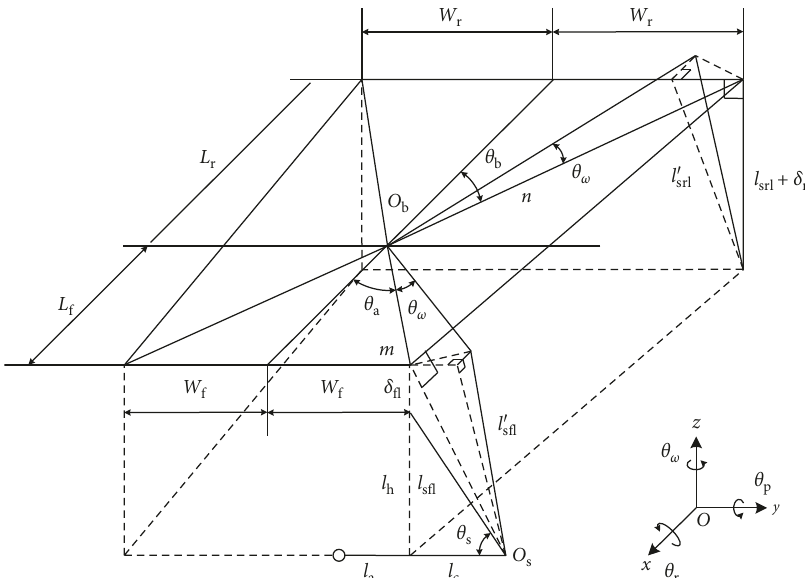
Figure 2: Diagram for calculating the deformation of front and rear suspensions when vehicle shimmy